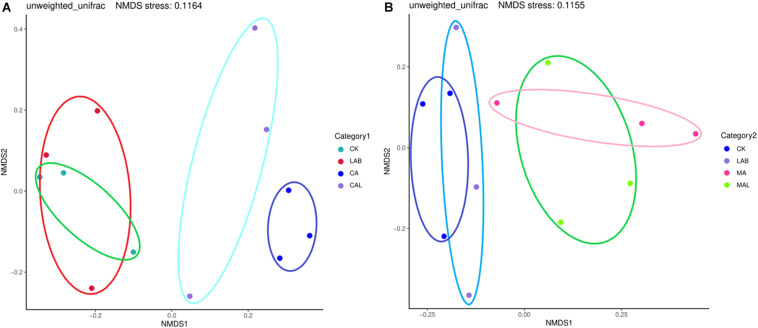
Representation of microbial beta diversity of CF silage treated with CA and Lactobacillus plantarum
(A), or MA and Lactobacillus plantarum
(B). CK, control; LAB, Lactobacillus plantarum; MA, malic acid; MAL, malic acid + Lactobacillus plantarum; CA, citric acid; CAL, citric acid + Lactobacillus plantarum.